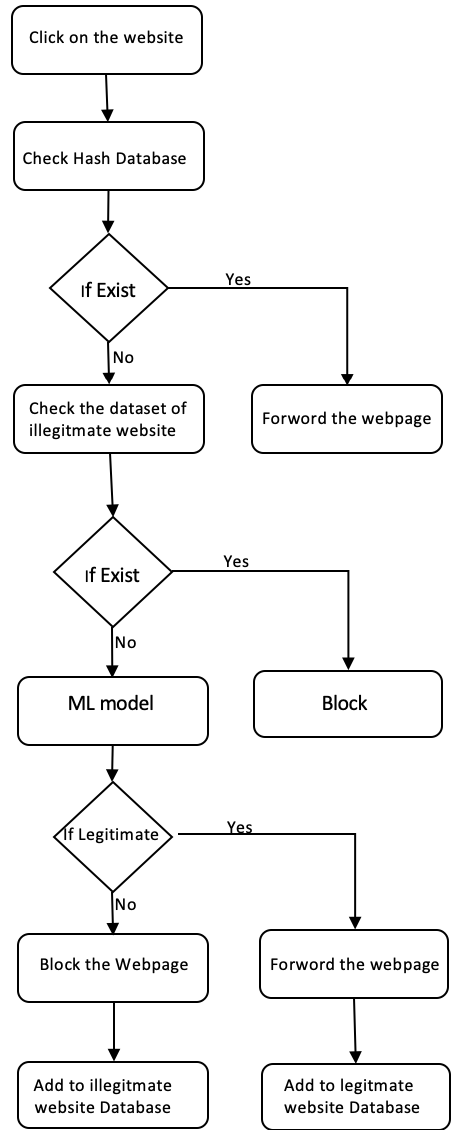
Figure 5. The sequential flow of the deployment